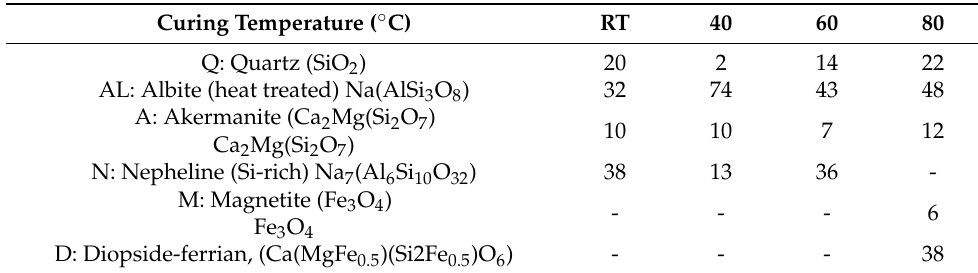
Table 2. Phase composition of the sintered kaolin-GGBS geopolymer